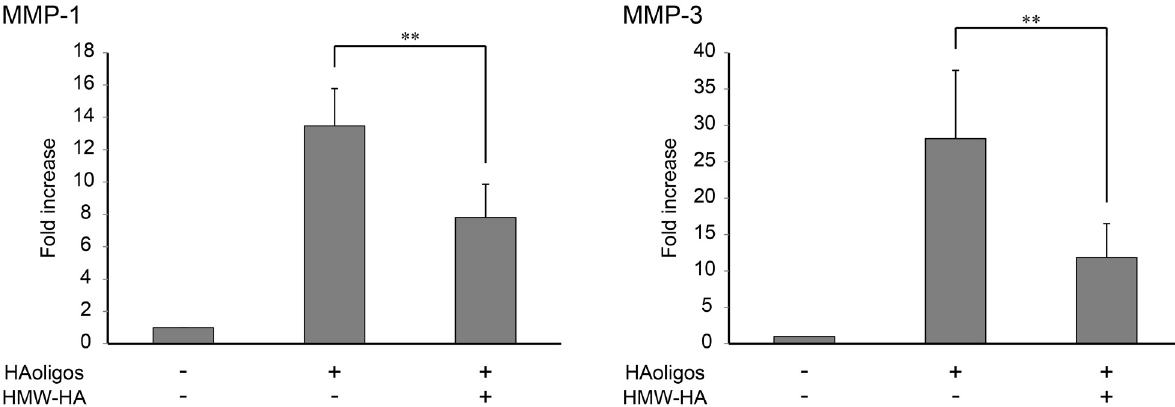
Fig 6. Effect of HMW-HA on MMP mRNA expression induced by HAoligo treatment. RSFs were treated with HAoligos (250 μ g/ml) for 12 hours. In next 12 hours, RSFs were treated with HAoligos (250 μ g/ml) or HMW-HA (1mg/ml). MMP-1 and MMP-3 expression levels were determined by quantitative real-time RT-PCR. Values are presented as mean ± S.D of two independent experiments analyzed in triplicate, and are expressed as n-fold increase relative to untreated control. ** p < 0.01 vs.